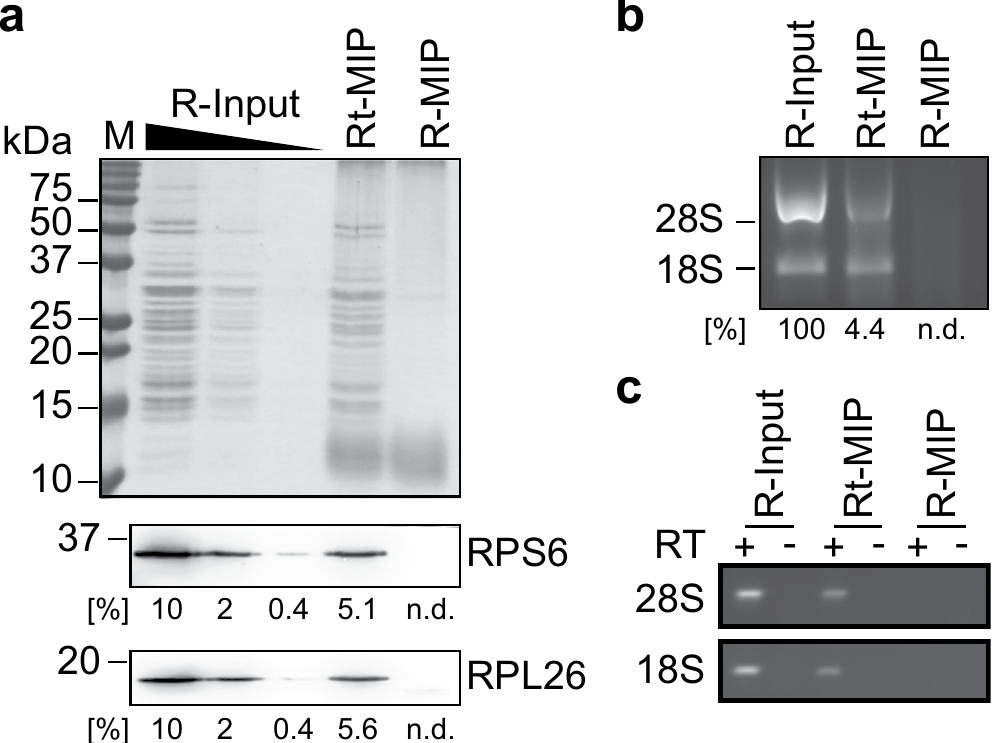
Figure 3. Imprinting and removal of template ribosomes from MIPs. ( a ) Coomassie stained PAA gel showing a titration of the purified ribosomes used for imprinting (R-input), and the content of sieved and granulated MIPs before (Rt-MIPs) and after (R-MIP) elution of the ribosome template. An immunoblot for detection of RPS6 (protein of the 40S subunit), and RPL26 (protein of the 60S subunit) is shown at the bottom. A quantification depicting the fraction of RPs compared to R-input (100%) is indicated at the bottom of each lane; no signal was detected for R-MIPs (n.d.). A molecular weight marker (M) is indicated to the left. ( b ) Agarose gels showing the same set of samples as in ( a ) to visualize 18S and 28S rRNAs as indicated. Bands corresponding to 18S and 28S rRNAs were quantified with ImageJ, and the averaged recovery (%) is indicated below the panel. No signal could be detected for R-MIPs (n.d.). Images of uncropped gels and blots are shown in the Supplementary Fig. S1. ( c ) RT-PCR for detection of indicated rRNA species. Control reactions without RT ( − ) are shown next to samples performed with RT ( +